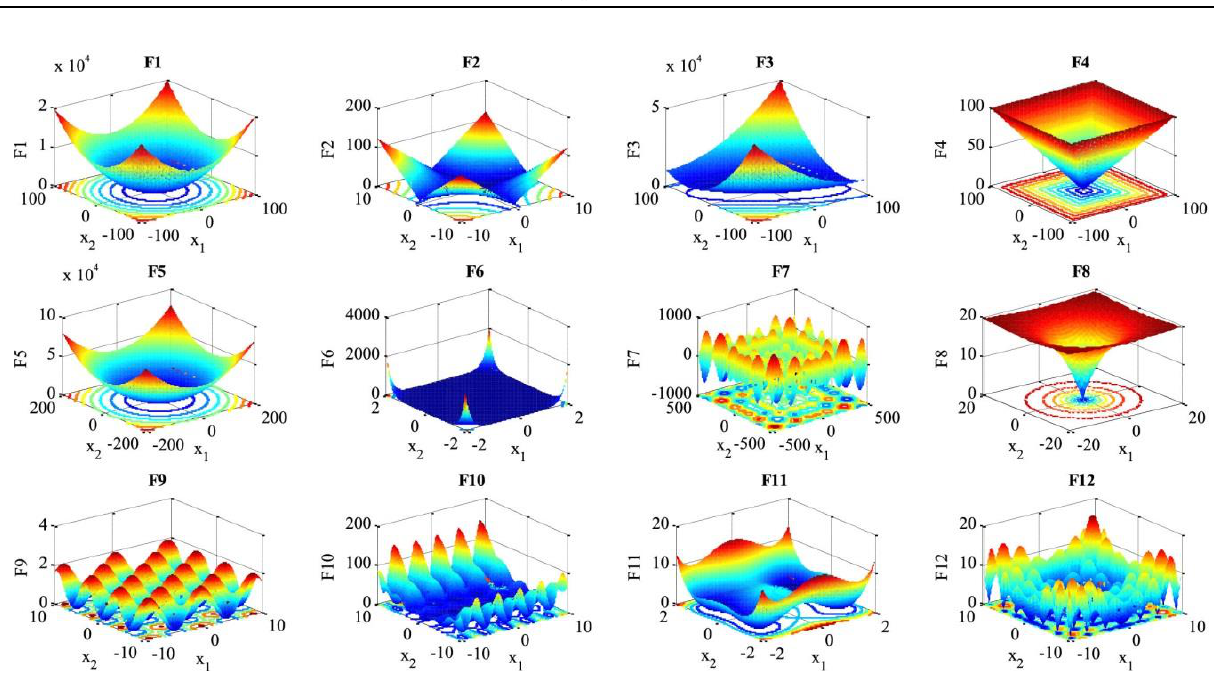
Figure 3. Perspective plots of the mathematical benchmark functions.